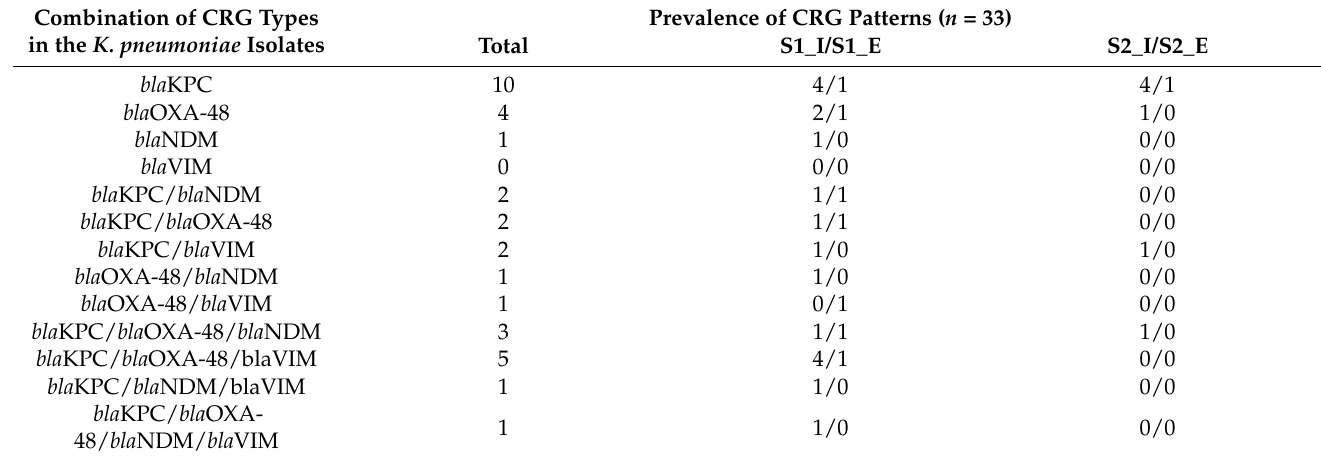
Table 1. The distribution of carbapenemase genes (CRGs) in Klebsiella pneumoniae isolates. Combination of CRG